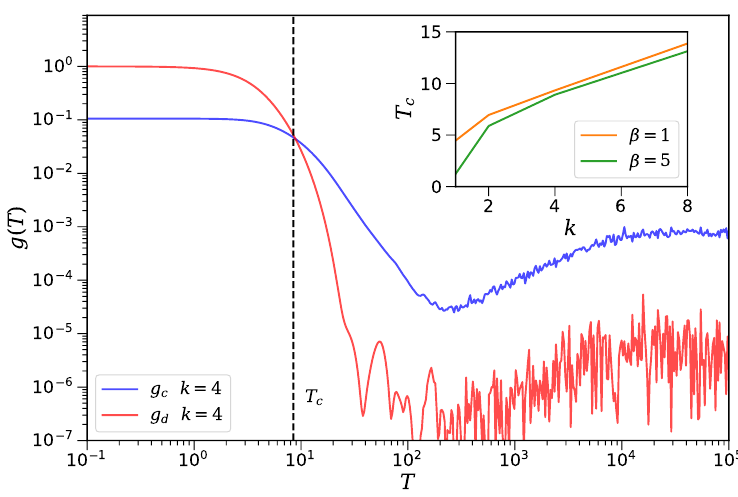
Figure 3 . Main: Exchange of dominance in the spectral form factor of sparse SYK model, for N = 30 , q = 4 , k = 4 , β = 5 , averaged over 100 disorder realizations. Inset: the critical time T c dependence on the sparsity k and inverse temperature β